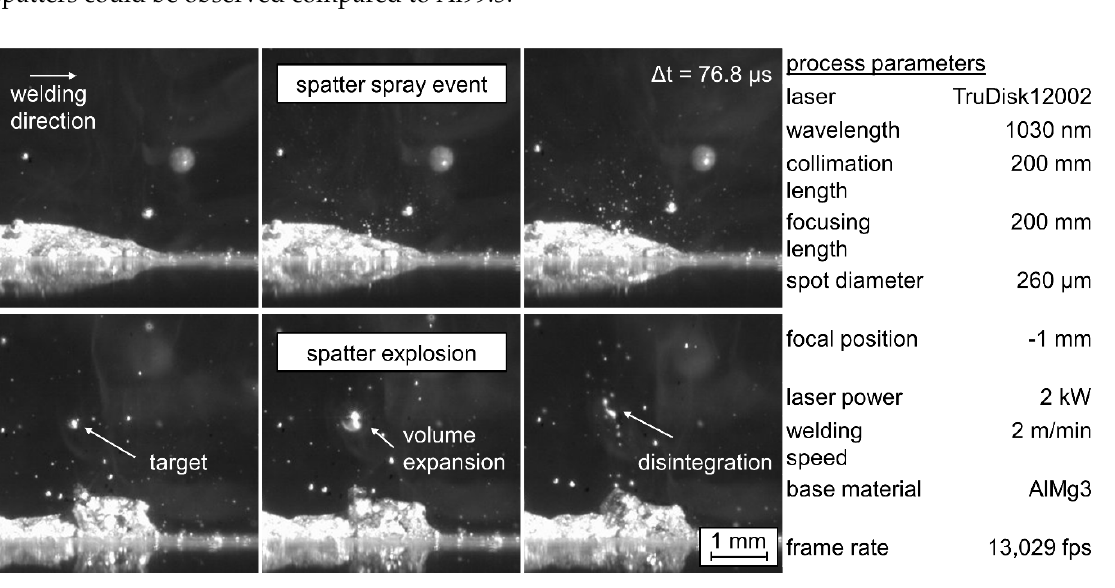
Figure 8. Frame series in the side view of a spray event and spatter explosion for AlMg5. While in the keyhole welding of pure aluminum (Al99.5) spatters resulted from rising melt columns accompanied by disintegration and eruptive spatter group ejections, additional events take place in the welding of AlMg alloys, such as spray events and, less frequently, spatter explosions. The process behavior in the welding of pure aluminum is calm in comparison to that of AlMg alloys. AlMg alloys show a rather unstable process behavior, with chaotic changes of the melt surface at the keyhole outlet region. This directly affects the visual appearance of the weld bead geometry.